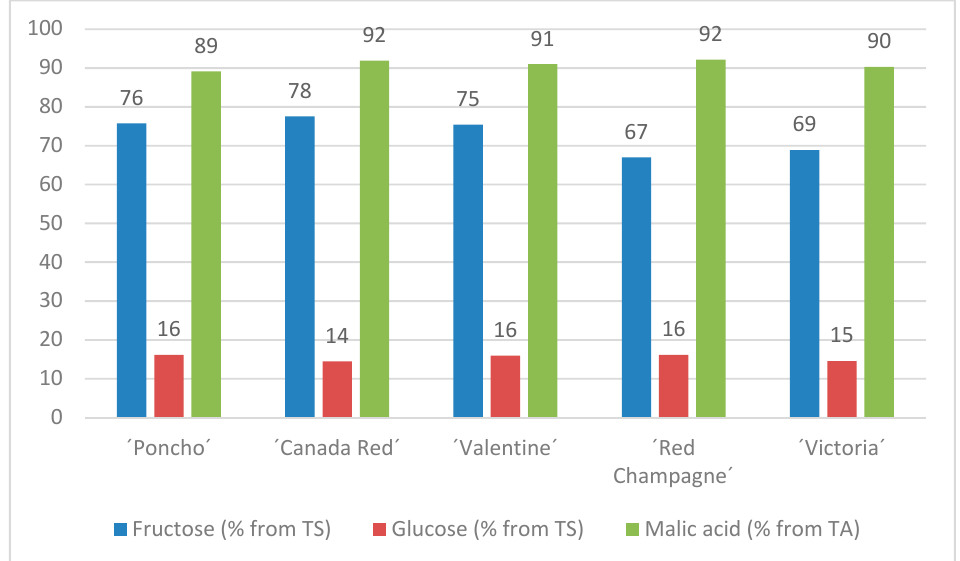
Figure 8. Share of fructose, glucose, and malic acid in total sugar and total acid content in the evaluated rhubarb cultivars. Table 2018. TS, total sugars and TA, total acid. Values are average from both harvests and years 2018–2019. Values with different letters in columns are significantly different at p < 0.05 by LSD test in ANOVA (Statgraphic XVII). Abbreviations: PON, ‘Poncho’; CRE, ‘Canadian